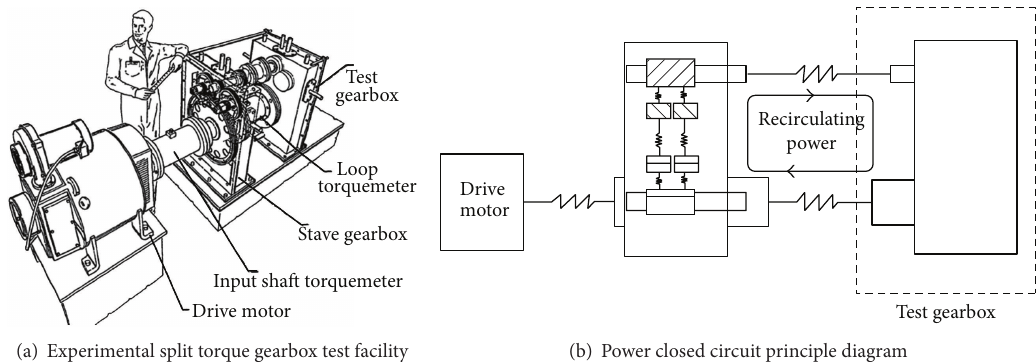
Figure 17: Experimental equipment and the principle